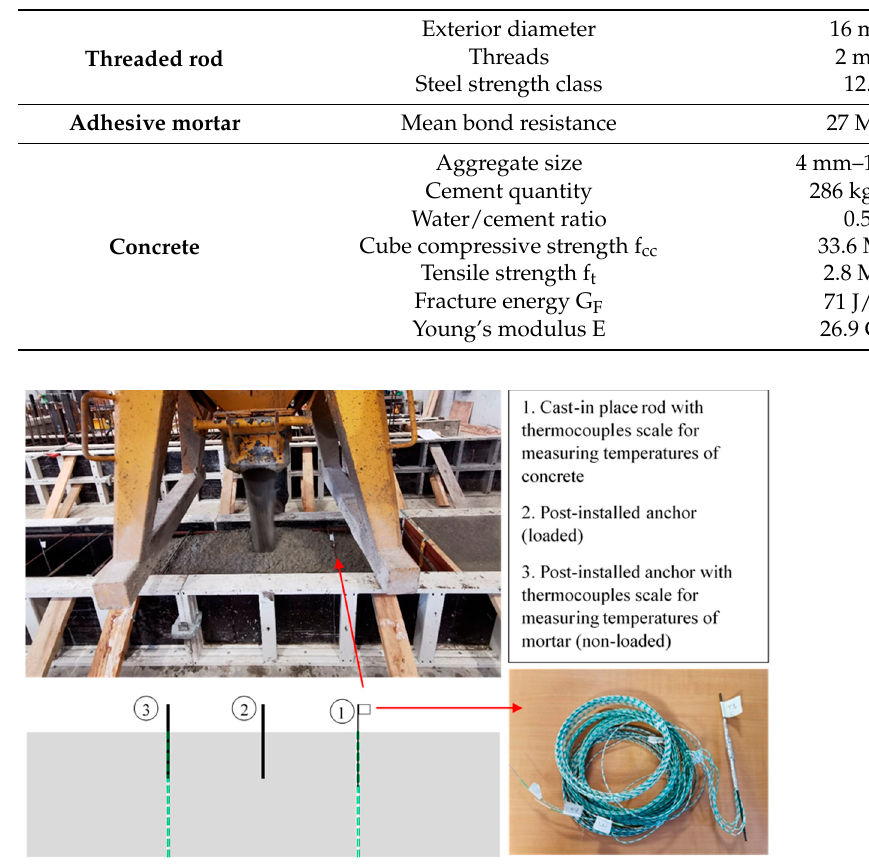
Figure 1. Positions of the